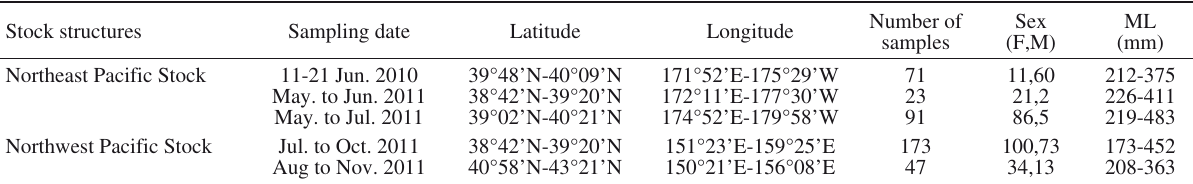
Table 1. – Sample information of O . bartramii for the two stocks. Stock